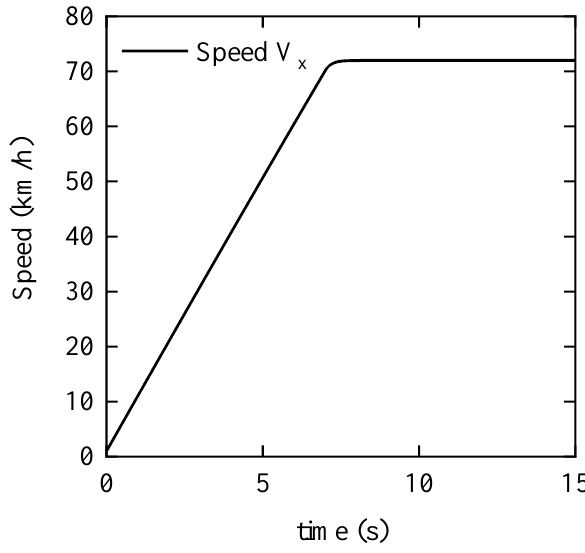
Figure 4. Longitudinal speed.